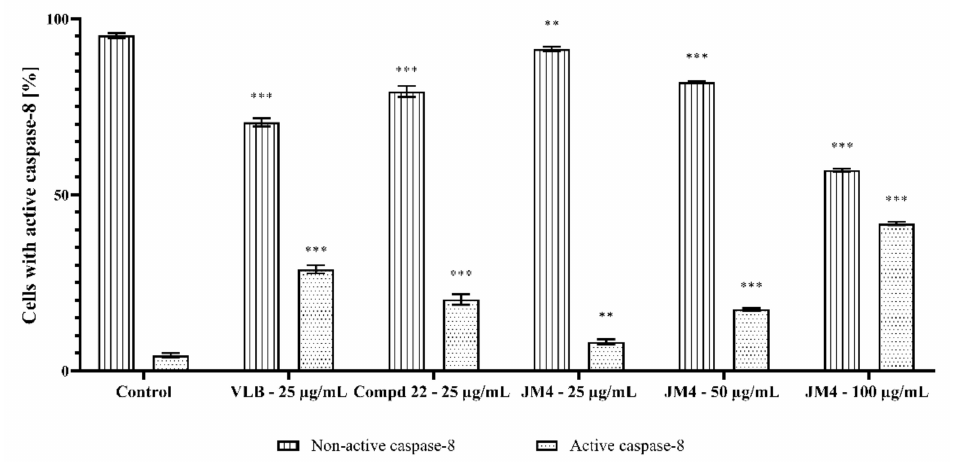
Figure 14. Percentage of C32 melanoma cells with nonactive and active caspase-8 after 24 h incubation with JM4 (25, 50, 100 µ g/mL), 22 (25 µ g/mL) and vinblastine sulfate (VLB) (25 µ g/mL). Mean percentage values from three independent experiments ( n = 3) done in duplicate are presented. ** p < 0.01 versus control group, *** p < 0.001 versus control